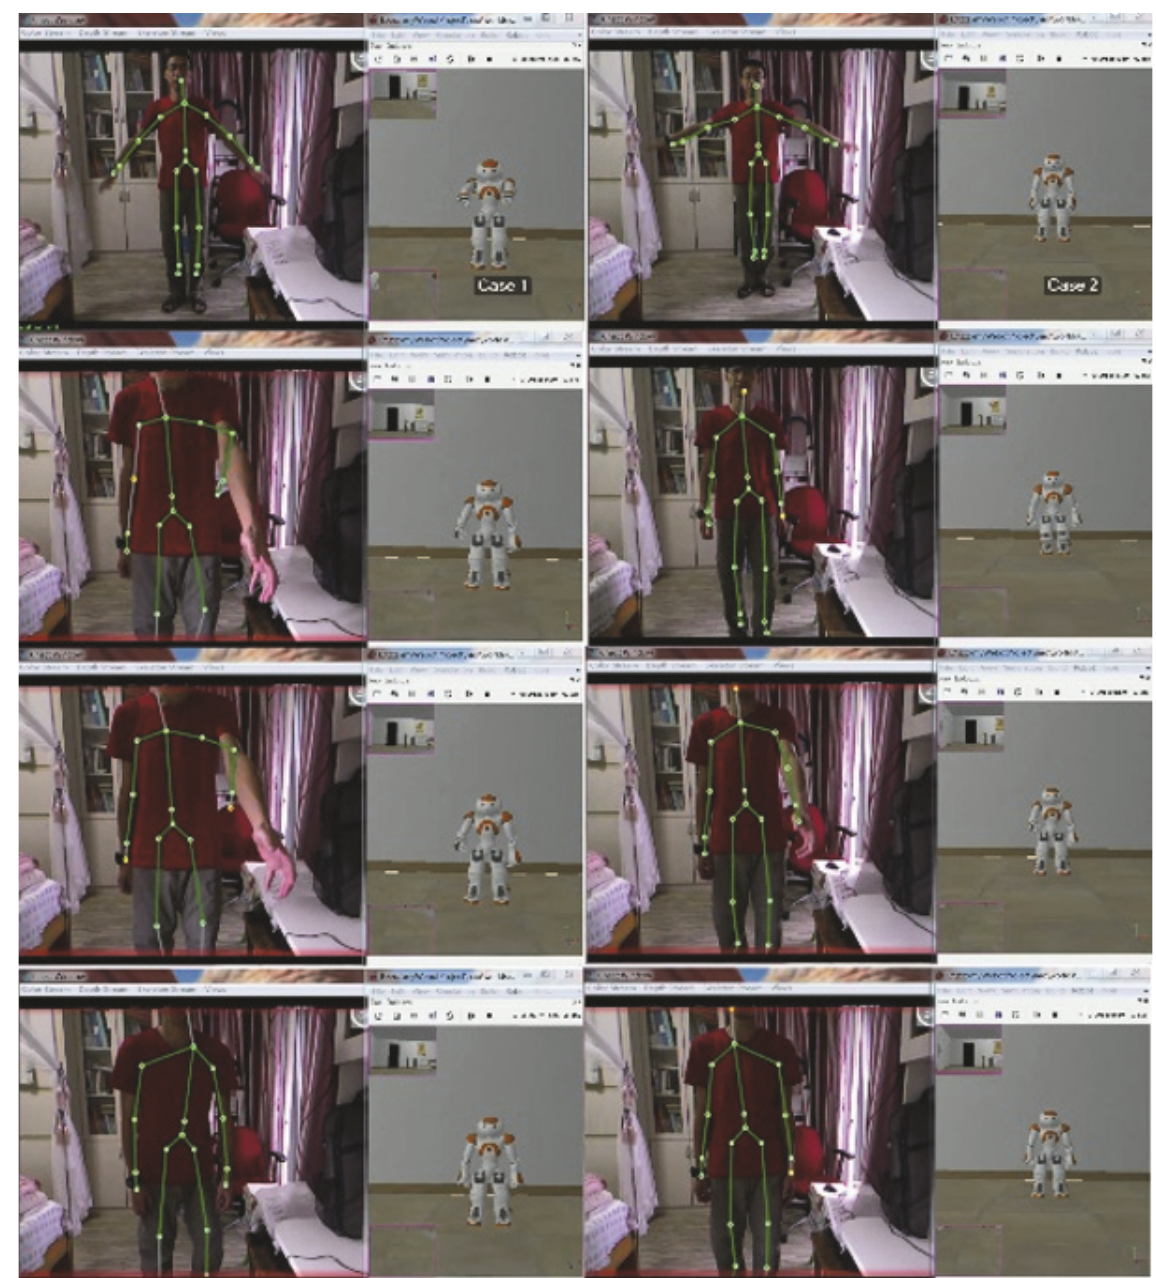
Figure 9: Grabbed frames of shaking hands learning in online